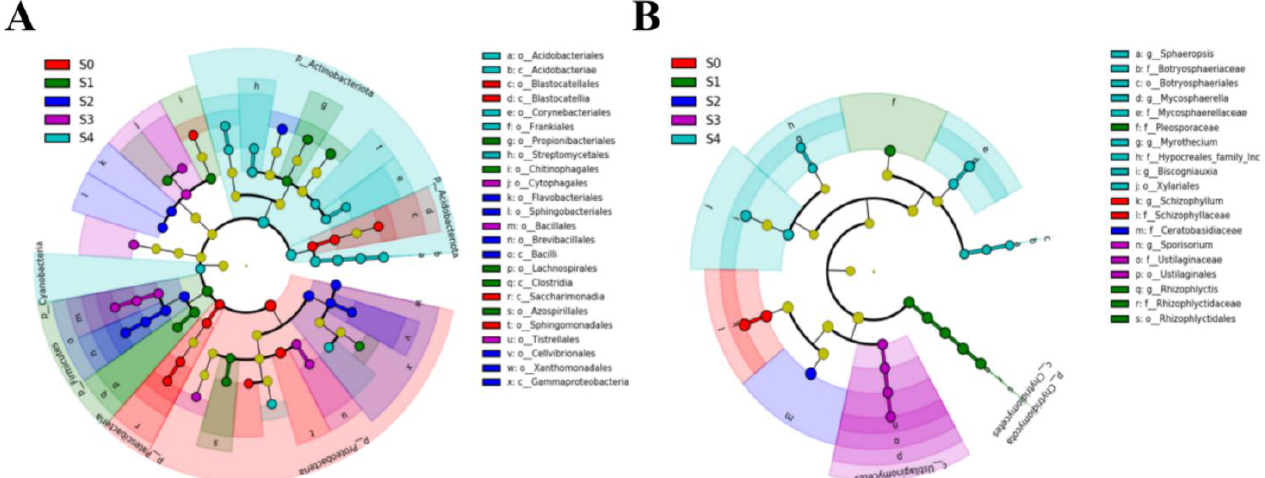
Figure 5. LDA Effect Size analysis of bacteria ( A ) and fungi ( B ) communities in poplar wood at different successional stages. Only effect sizes with LDA > 4 for bacterial communities, and LDA > 2 for fungal communities are shown.